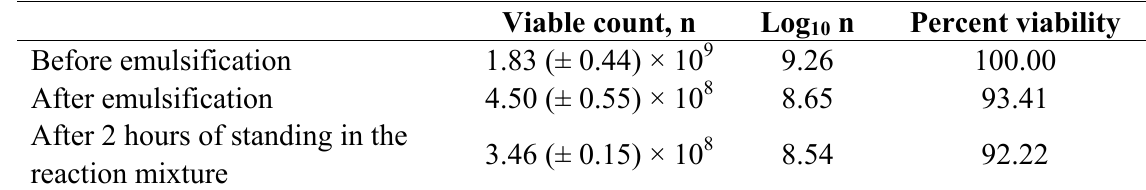
Table 1. Viability of yeast cells subjected to the emulsification process.